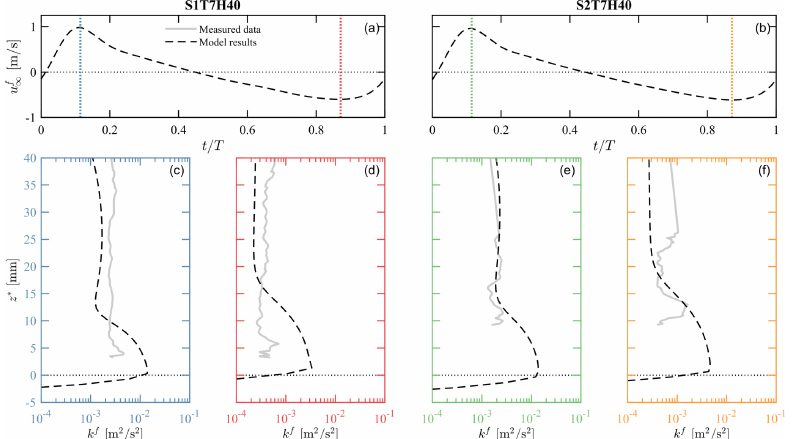
Figure 7. Time series of modeled free stream velocity for ( a ) S1T7H40 and ( b ) S2T7H40. ( c – f ) are measured (gray solid curves) and modeled (black dashed curves) vertical profiles of turbulent kinetic energy, k f ( z ∗ , t / T ) , under ( c , e ) the wave crest ( t / T = 0.114) and ( d , f ) wave trough ( t / T = 0.871), as denoted in ( a , b ) using vertical dotted lines with corresponding colors.